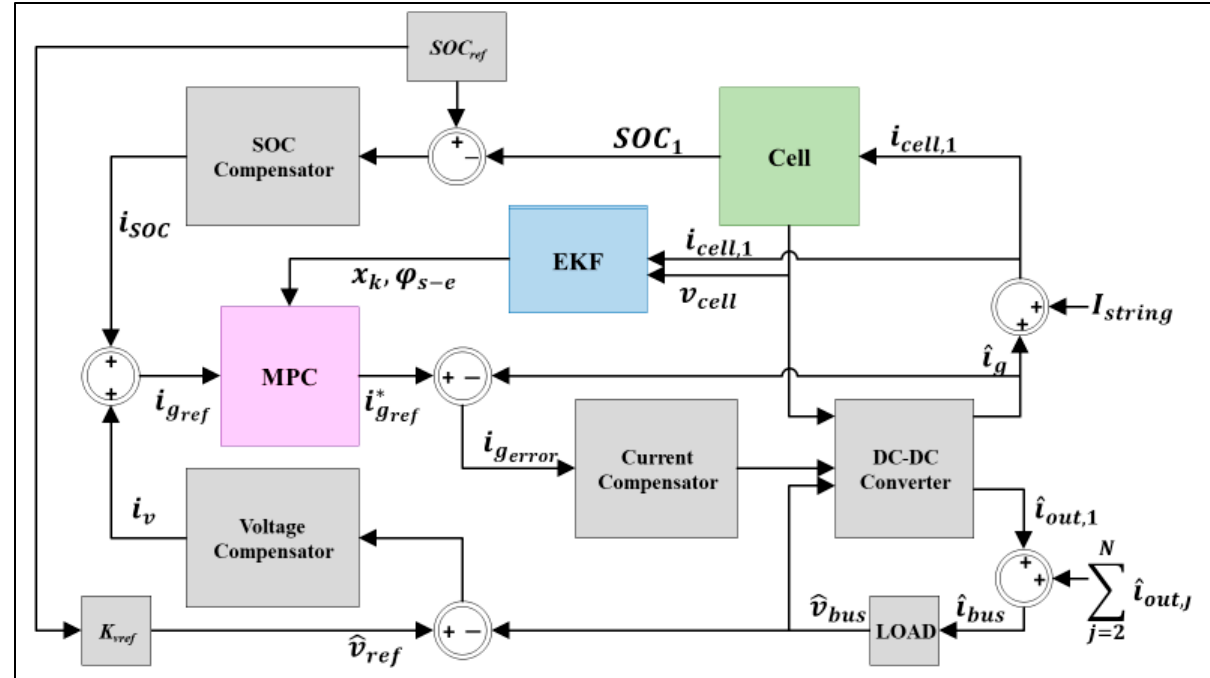
Figure 2. Block diagram of the BMS utilizing PB ‐ EKF ‐ MPC for smart sensor.